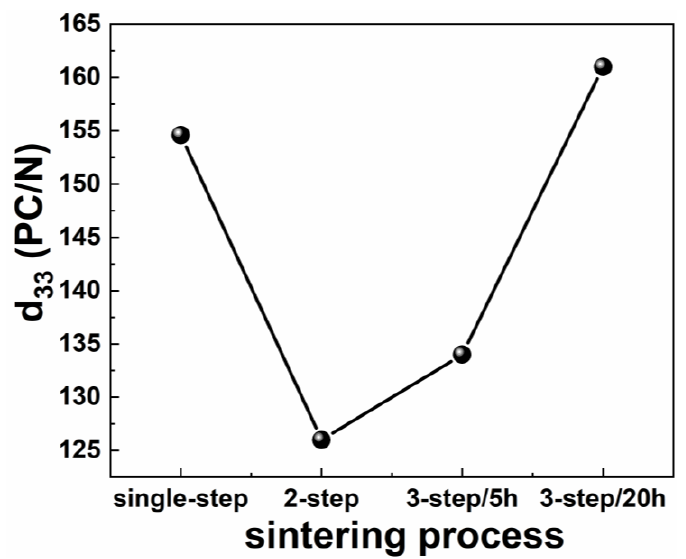
Figure 4. Piezoelectric coefficients of 0.92KNLN-0.08BZ ceramics sintered under different condi- tions.